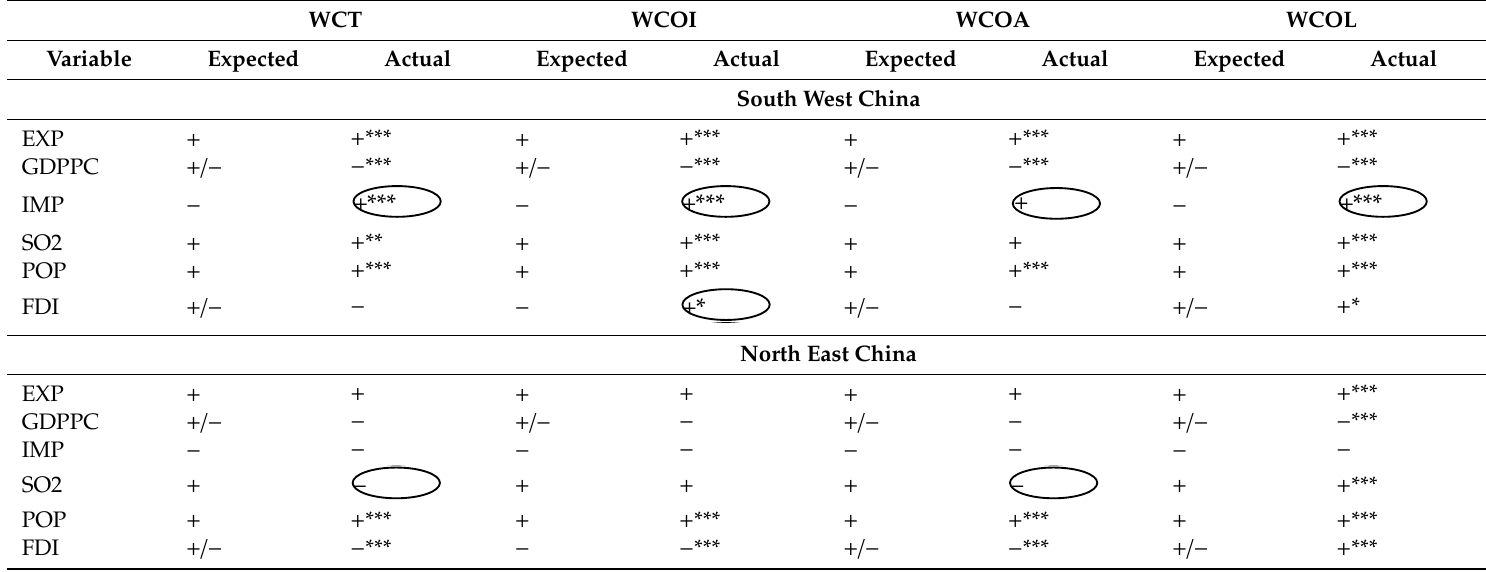
Table 9. FMOLS estimates and the sign comparison—expected versus actual.